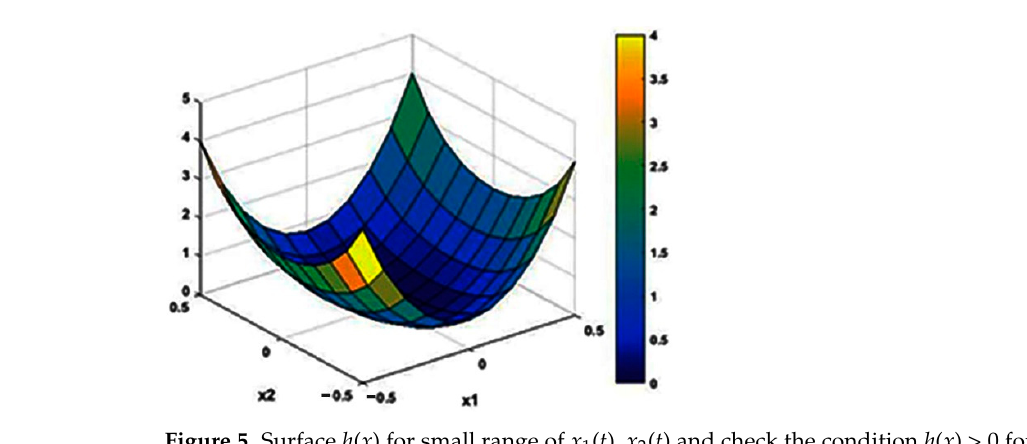
Figure 5. Surface h ( x ) for small range of x 1 ( t ), x 2 ( t ) and check the condition h ( x ) > 0 for stability of nonlinear system (34).